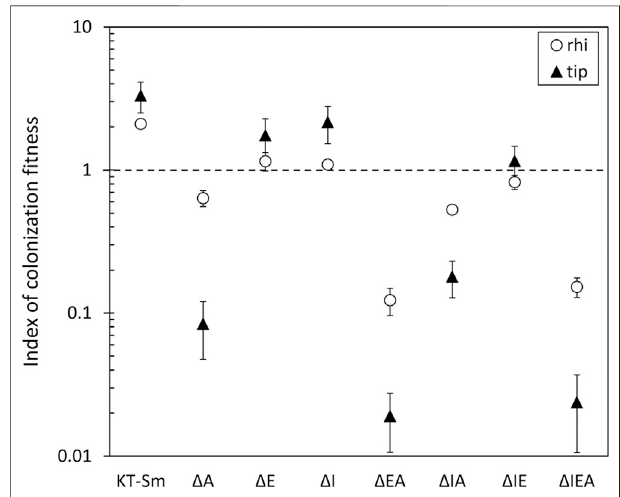
FIGURE 6 | Colonization capacity of mutants in rsm genes in competition with the wild type in the rhizosphere (circles) and the root tip (triangles)of corn plants. KT2440 tagged with miniTn7-Km was co-inoculated in a 1:1 proportion with each of the mutants, which were tagged with miniTn7-Sm.Tocheckthepotentialeffectoftheantibioticresistancemarkers, a competitive colonization assay co-inoculating KT2440 miniTn7-Km and KT2440 miniTn7-Sm (KT-Sm) was also included as control. The index of colonization fi tness was measured as 1/[(percentage of recovered wild type vs. each mutant per plant 7 days post-inoculation)/(percentage wt vs. mutant in the initial inocula)]. A value of 1 (broken line) indicates equal colonization capacity. Data are the averages and standard errors for six